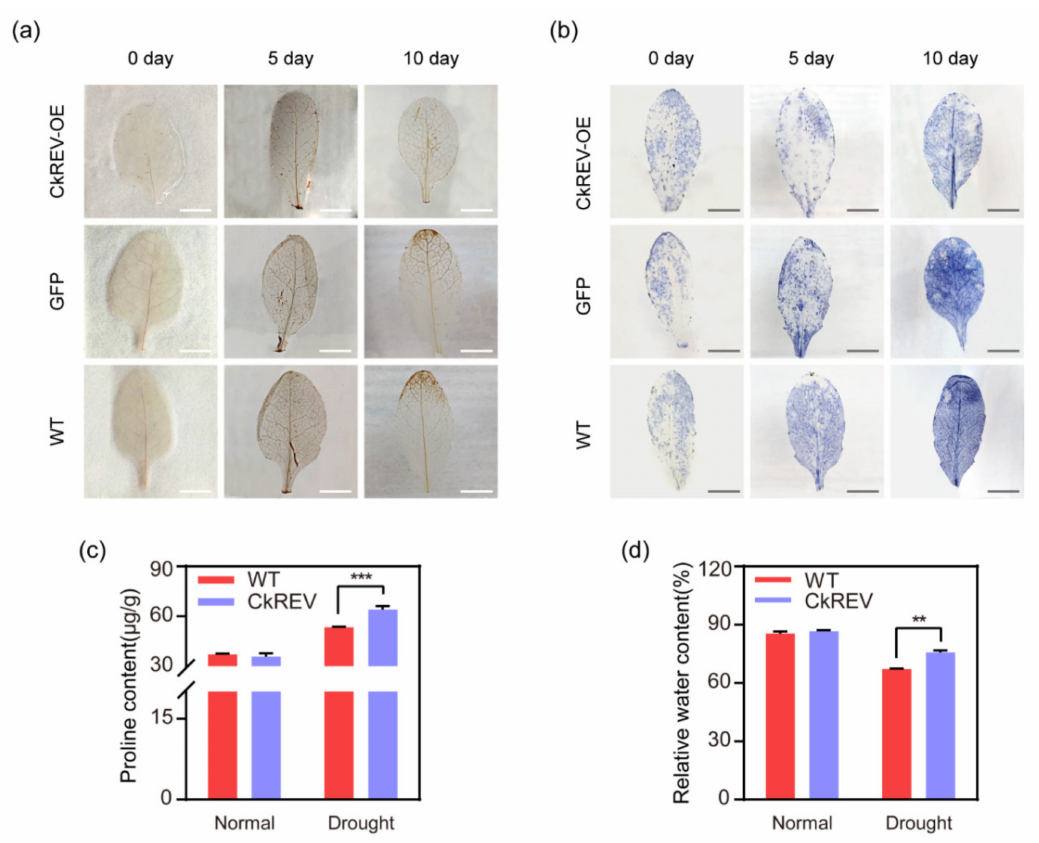
Figure 7. Phenotype analysis on transgenic A. thaliana . ( a ) DAB staining on rosette leaves at the same position after natural drought treatment for 0, 5, and 10 days (n = 3 biologically independent samples); ( b ) NBT staining on rosette leaves at the same position after natural drought treatment for 0, 5, and 10 days (n = 3 biologically independent samples); ( c ) Results of proline content determination; ( d ) Results of relative water content determination. Scale bars in ( a , b ), 5 mm. ( c , d ) Data are shown as the mean ± SD of three independent experiments. Student’s t –test is employed to measure statistical significance between two samples with a confidence level of 0.95 (**, p < 0.01; ***, p <